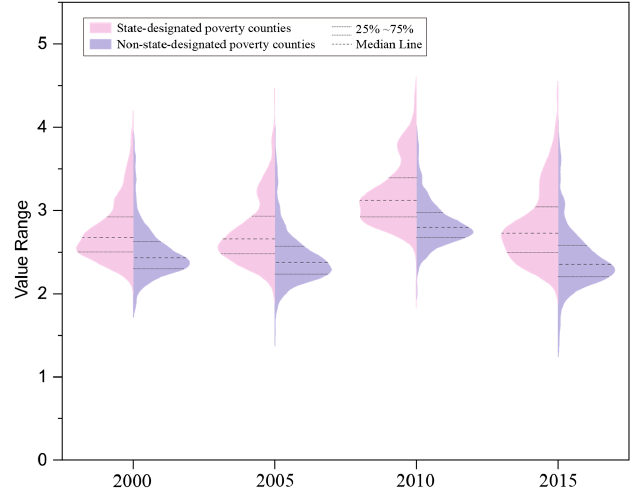
Figure 7. Violin plot of the CMPI in state-designated poverty counties and non-state-designated poverty counties.